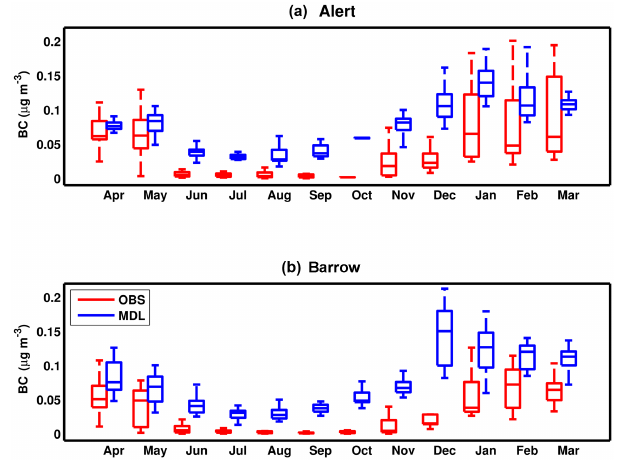
Figure 5. Comparison of simulated BC with observations shown as box-and-whisker plots over the simulations period at the Alert (a) and Barrow (b) sites. In the box-and-whisker plots, the middle line denotes the median value, while the edges of the box represent 25th and 75th percentile values, respectively. The whiskers denote the maximum and minimum values.